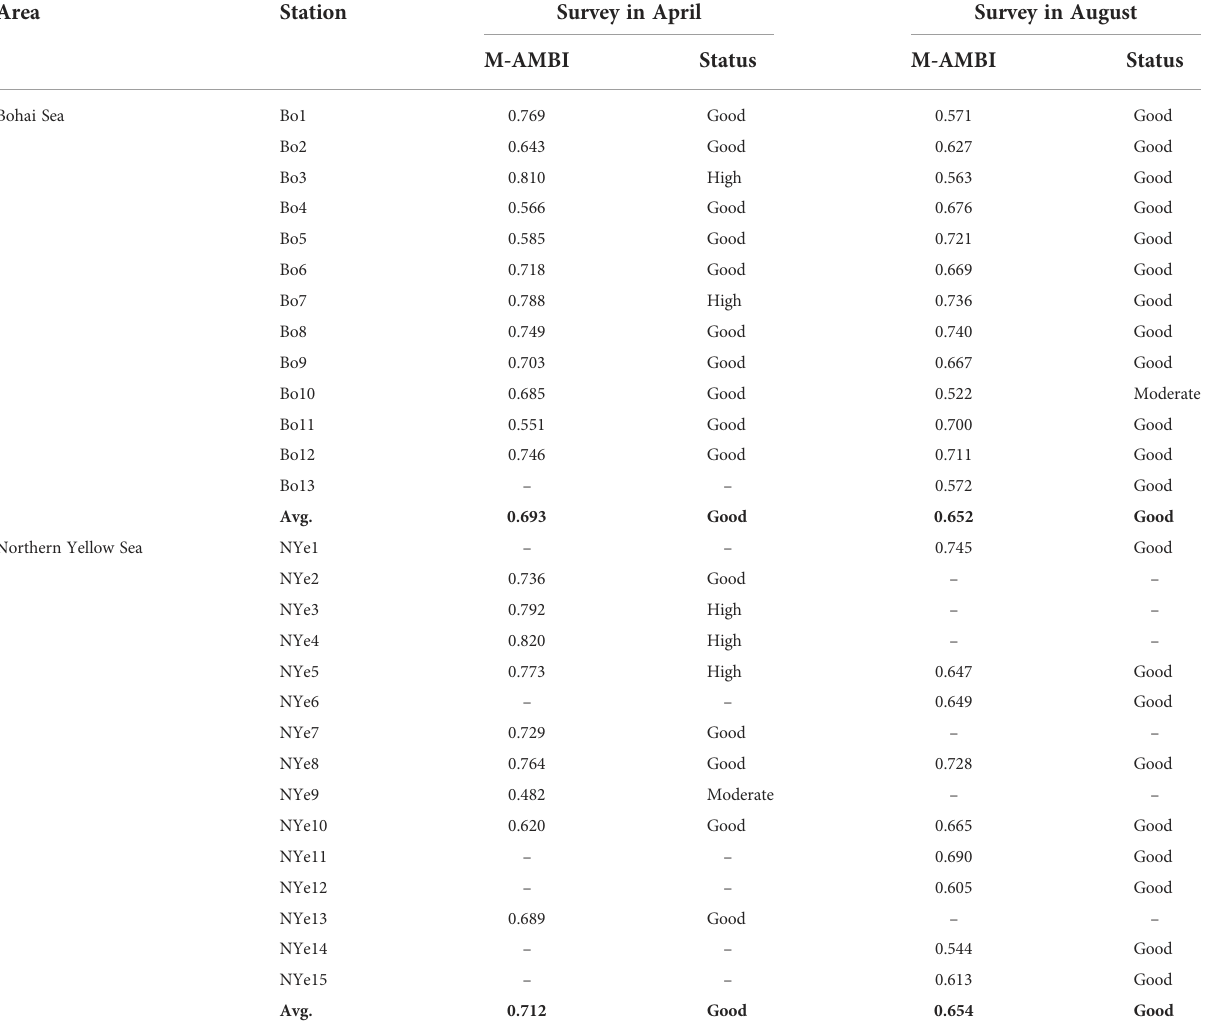
TABLE 5 Values of M-AMBI and the corresponding ecological quality status, by month, in the Bohai Sea and northern Yellow Sea areas off Yantai, China.